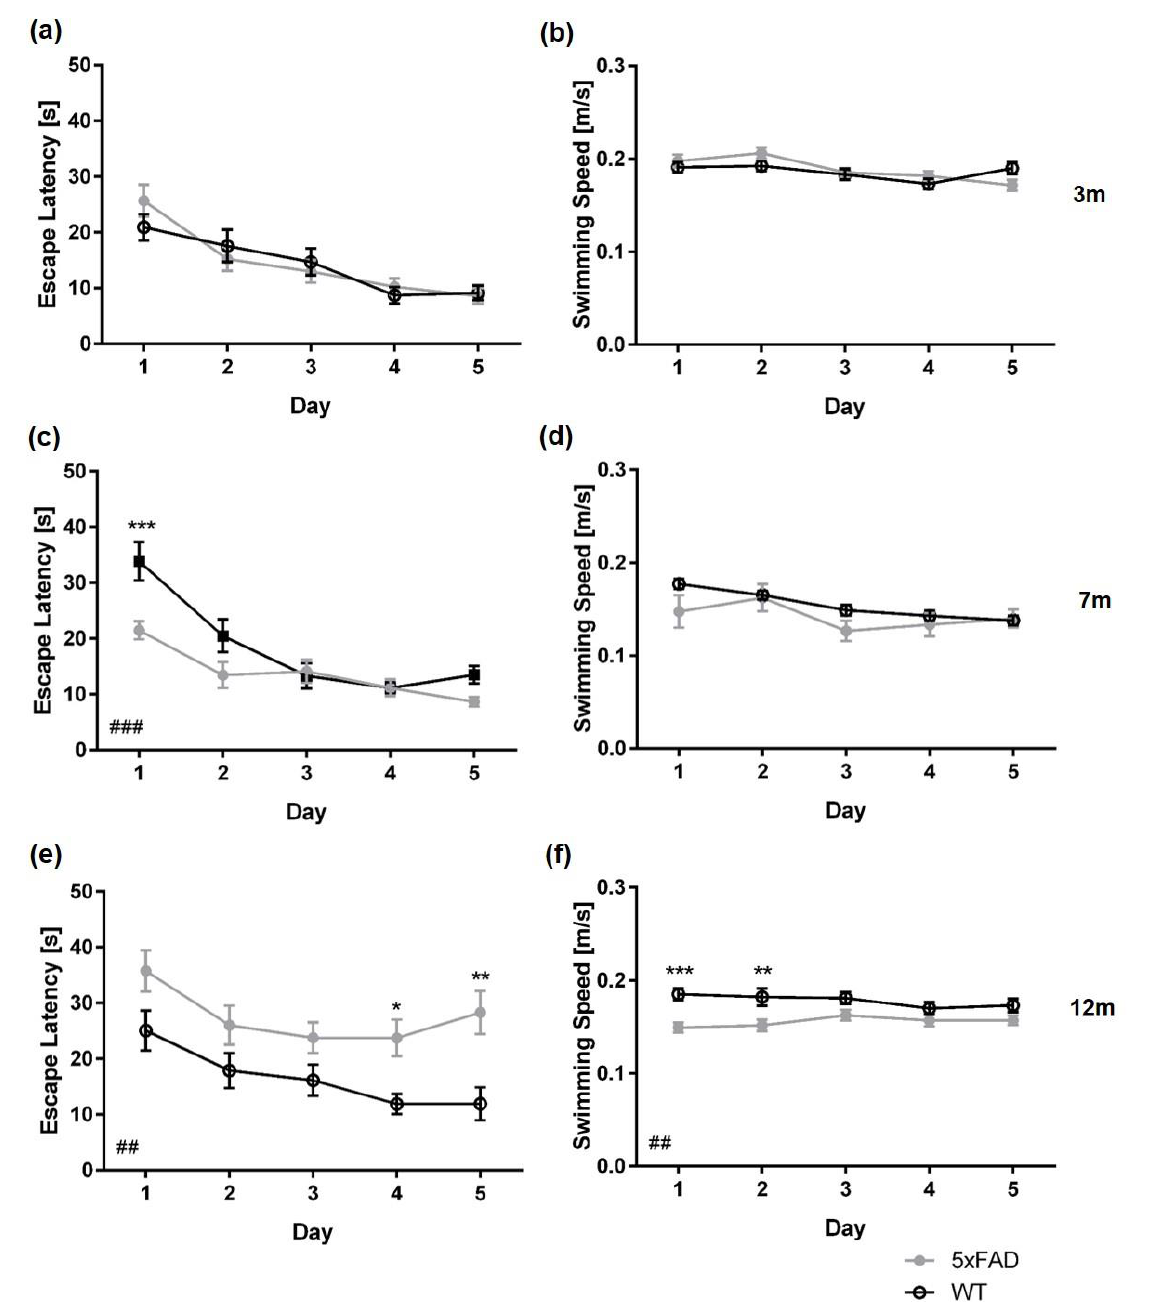
Figure 3. Male 5xFAD mice display age-dependent spatial learning deficits in the acquisition training. Escape latencies and swimming speed of 3- ( a , b ), 7- ( c , d ), and 12-month-old mice ( e , f ). Data presented as mean ± S.E.M., n = 10–13. Two-way repeated measures ANOVA: ## p < 0.01; ### p < 0.001; Bonferroni: * p < 0.05, ** p < 0.01, *** p < 0.001. Furthermore, 12-month-old male 5xFAD mice performed significantly better than same-aged female 5xFAD mice (F(1,22) = 4.519, p = 0.045). Swimming speed did not differ between female WT and 5xFAD mice at any age tested (Figure 2b,d,f: 3 m F(1,23) = 0.06218, p = 0.8053; 7 m F(1,24) = 1.465, p = 0.2379; 12 m F(1,21) = 0.0930, p = 0.7634). In addition, swimming speed between three- and seven-month- old male WT and 5xFAD mice did not differ significantly (Figure 3b,d: 3 m F(1,24) = 1.774, p = 0.1960; 7 m F(1,24) = 2.213, p = 0.1480). In contrast, 12-month-old male 5xFAD